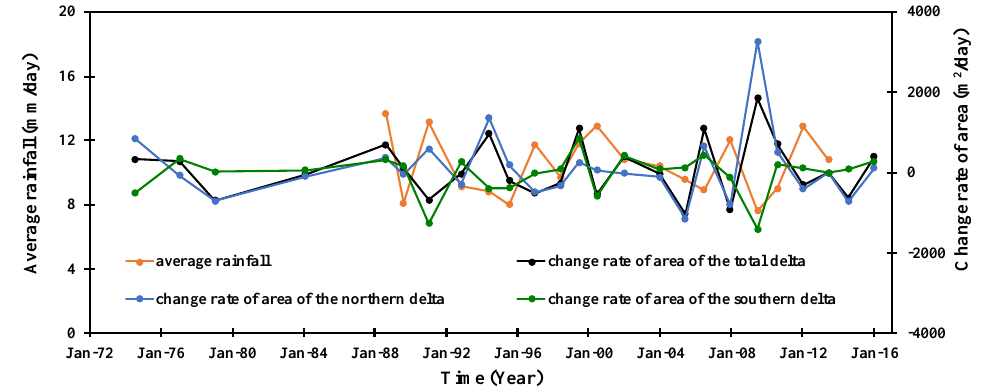
Figure 14. Relation between the change rates of the area of the delta (total, northern, and southern) and average daily rainfall.